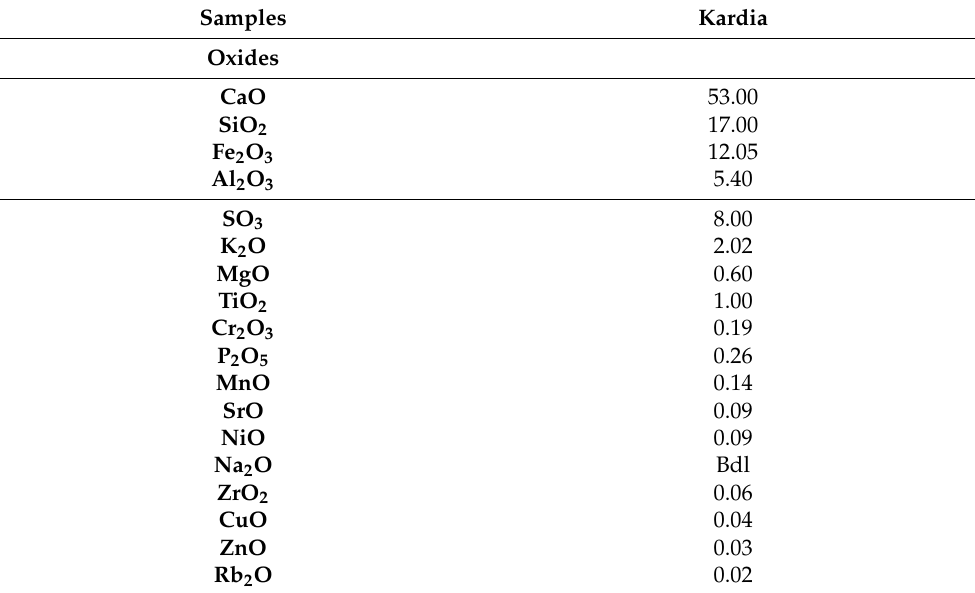
Table 5. Chemical composition (in %) of the fly ash under study (bdl: below detection limit).